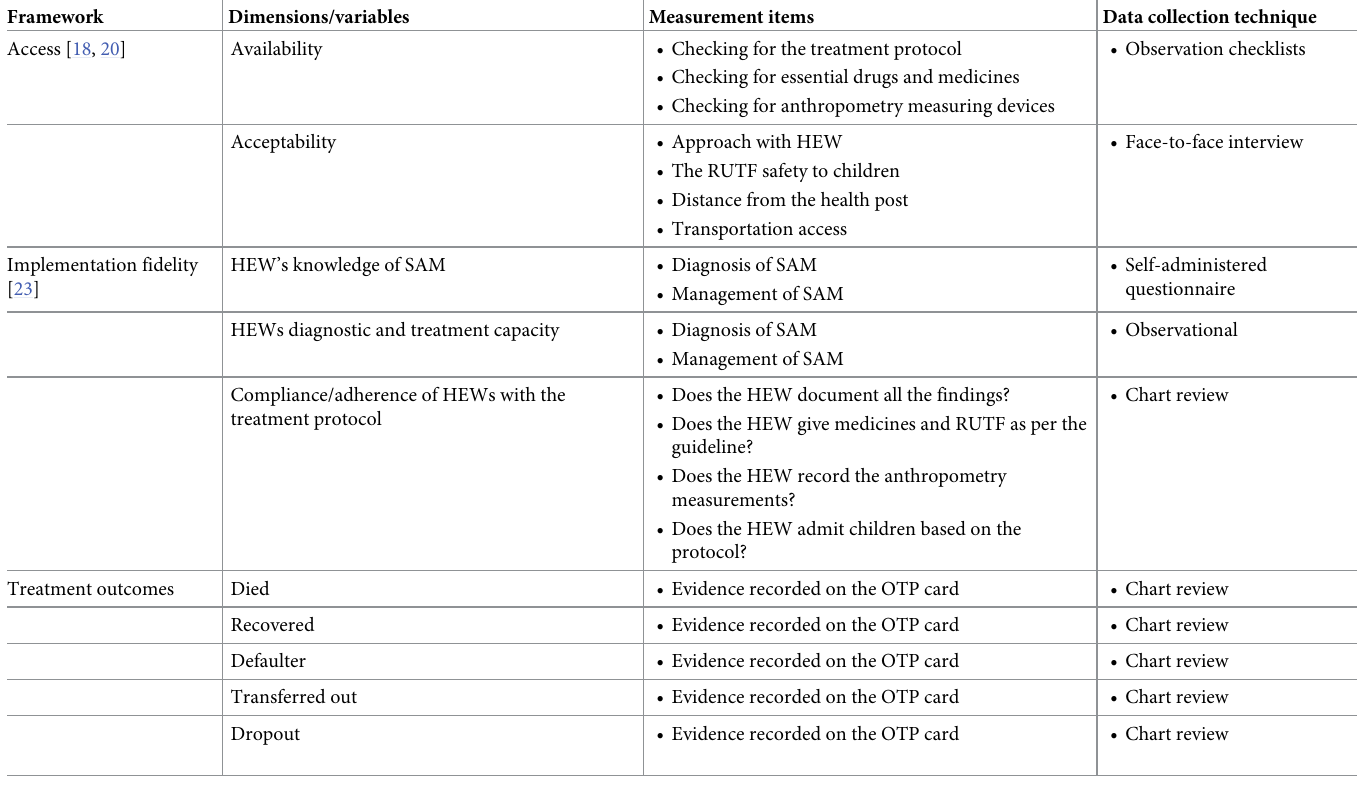
Table 1. Summary of the dimensions/variables of implementation evaluation of C-OTP and measurements in Central Gondar zone, Ethiopia, 2021. Framework